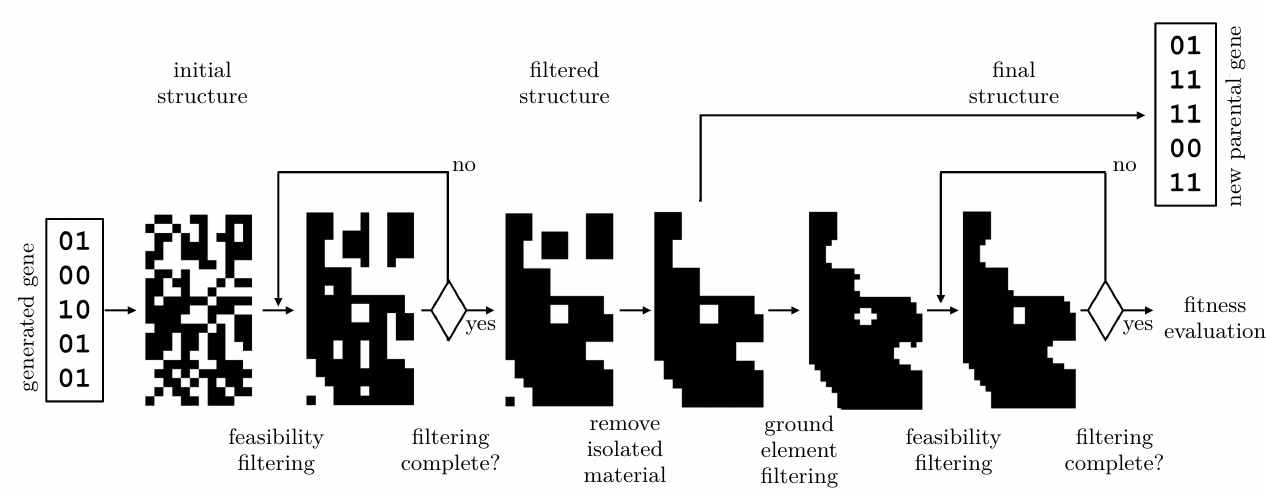
Figure 6. Application of the genotype-phenotype mapping on a randomly generated parameter set. The binary gene corresponds to a material distribution in a rectangular design domain. The feasibility filter is applied repeatedly until further application of the filter no longer changes the shape (filtering complete). Isolated material is subsequently removed and the structure is mapped to a finer mesh by Ground Element Filtering. The feasibility filter is applied again to the fine mesh to achieve the final structure used for fitness